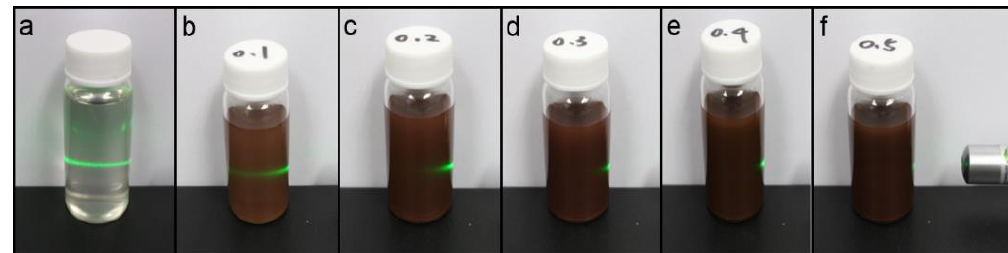
Figure 2. Tyndall effect of ( a ) HPMC solution, ( b ) 0.1% G/Cu slurry, ( c ) 0.2% G/Cu slurry, ( d ) 0.3% Figure 2. Tyndall e ff ect of ( a ) HPMC solution, ( b ) 0.1% G / Cu slurry, ( c ) 0.2% G / Cu slurry, ( d ) 0.3% G / Cu G/Cu slurry, ( e ) 0.4% G/Cu slurry, and ( f ) 0.5% G/Cu slurry. slurry, ( e ) 0.4% G / Cu slurry, and ( f ) 0.5% G / Cu slurry.